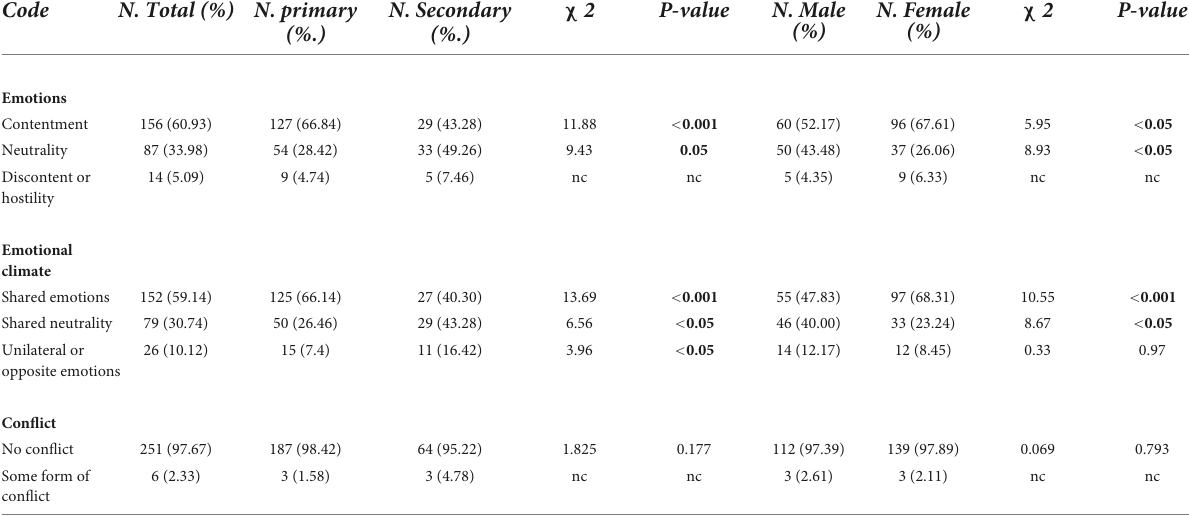
TABLE 3 Quantitative content analysis of the selected PAIR items for emotions, relationships, and conflicts ( N = 257). Code N. Total (%) N. primary N. Secondary (%.) (%.)